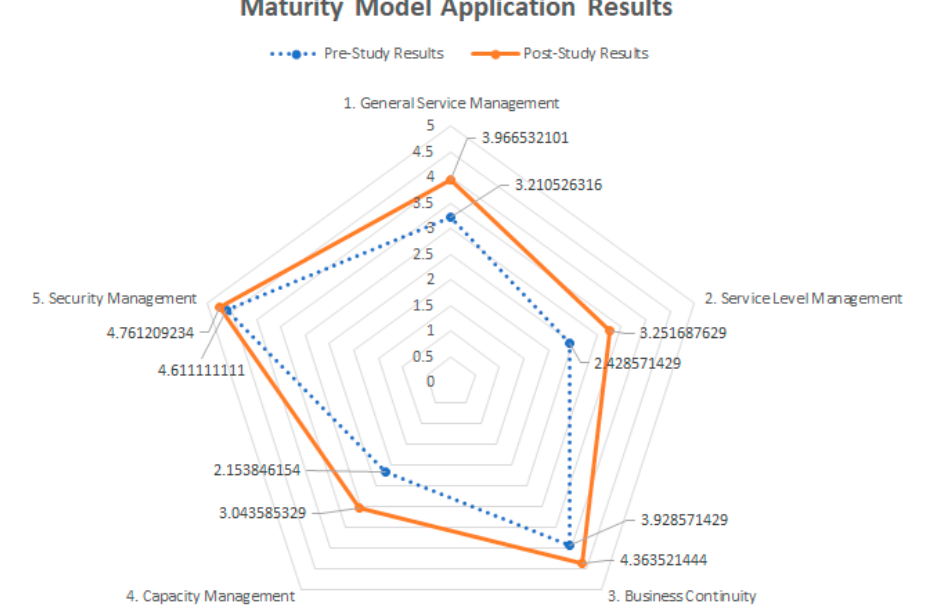
Figure 1. Maturity Model Application Results.